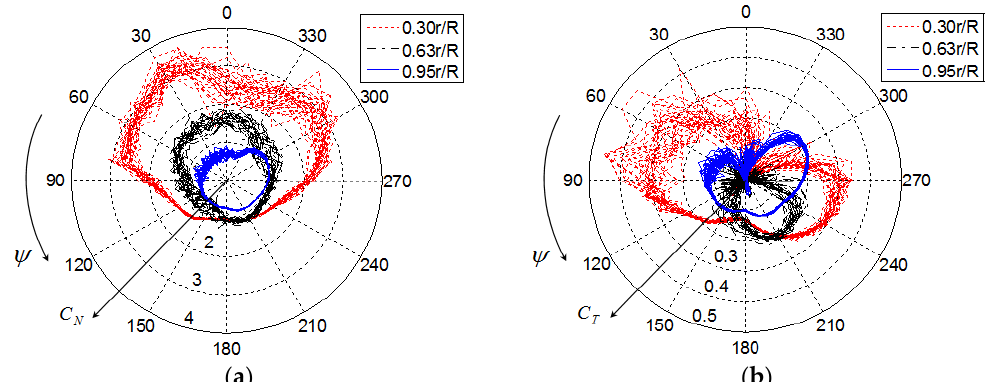
Figure 1. Distributions of the unsteady normal and tangential force coefficients against the blade azimuth angle (Ψ) at three radial locations and 36 rotor rotations (cycles) at wind speed 15 m/s and yaw angle 30°. ( a ) Normal force coefficient ( C N ); ( b ) Tangential force coefficient ( C T ).